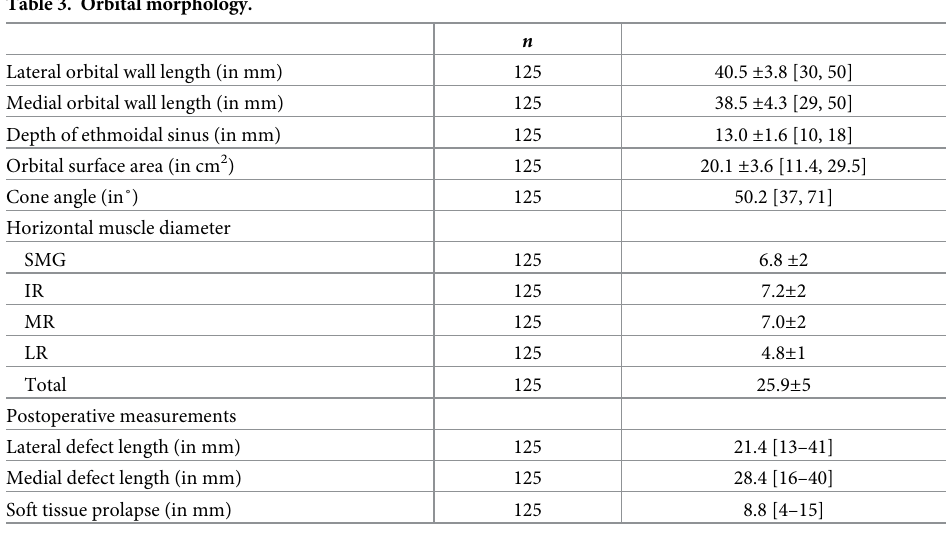
Unless otherwise stated data are means ± SD or median [Range] SMG: Superior muscle group (M. rectus superior and levator palpebrae